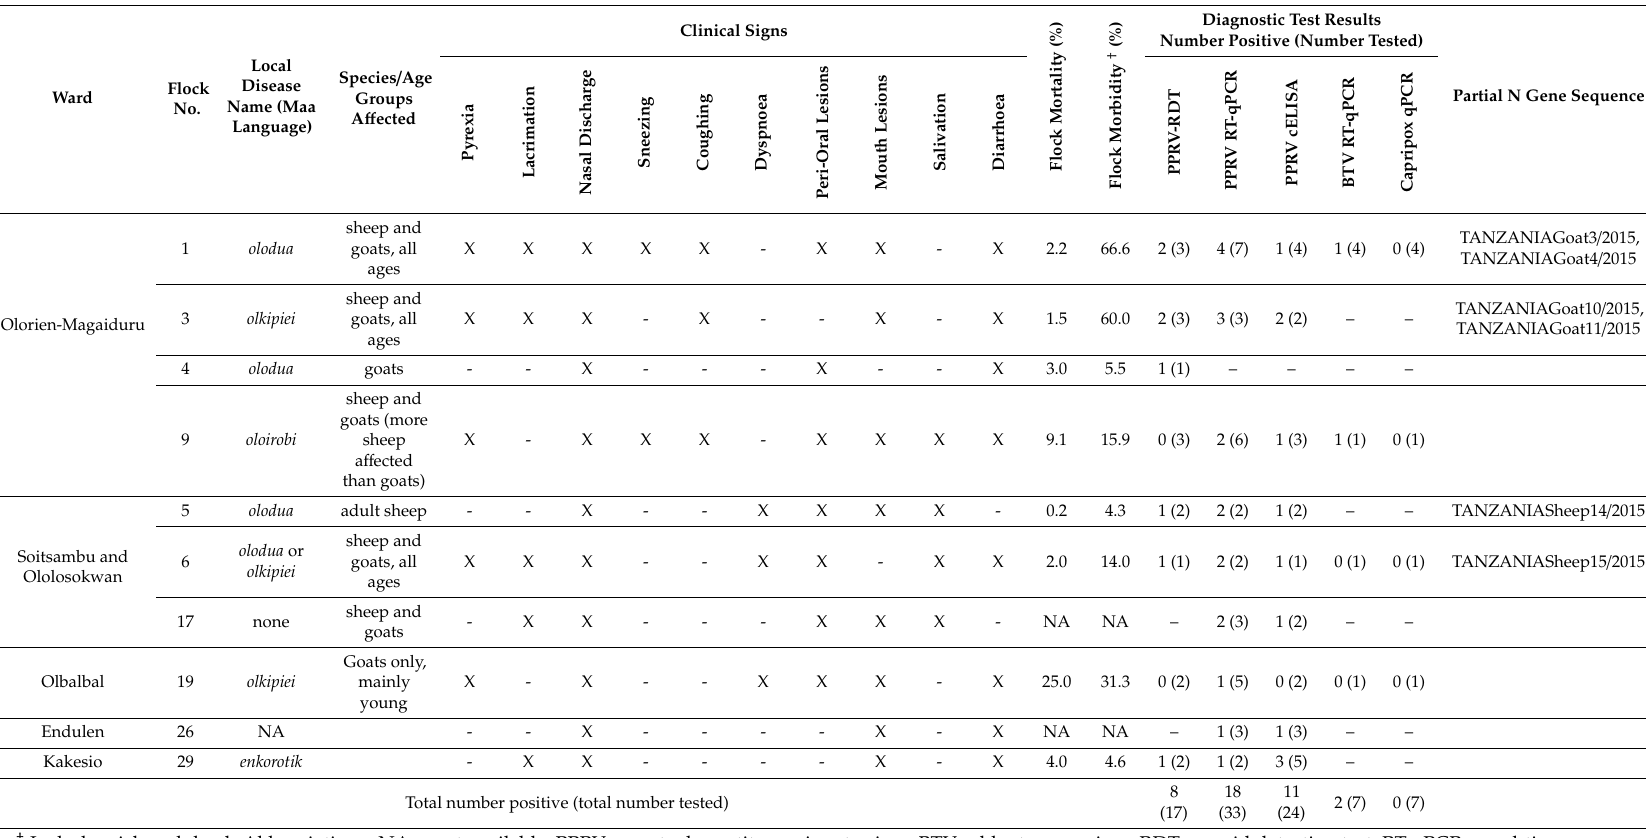
Table 1. Summary of the characteristics of confirmed peste des petits ruminants (PPR) outbreaks and diagnostic test results in Ngorongoro District, June–July 2015.